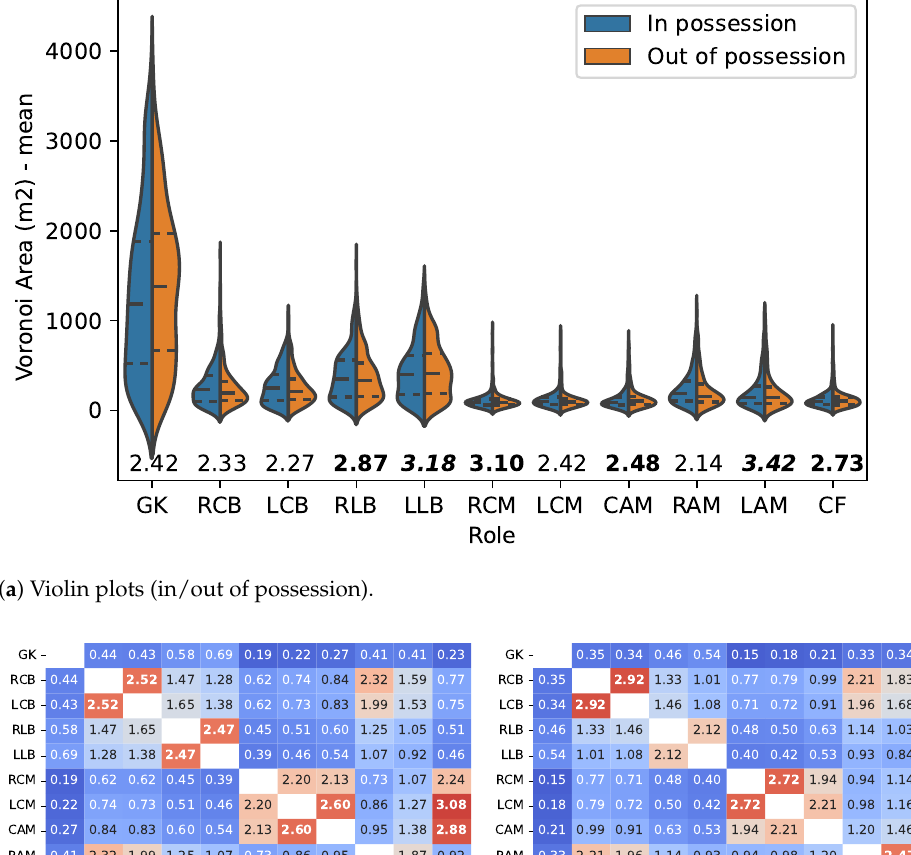
( b ) KS heatmap (in possession). Figure 2. Players’ Voronoi area probability density function in the 4-2-3-1 team formation. Note: Violin plots ( a ) and heatmaps ( b , c ) comparing players’ Voronoi area probability density function (less similar in blue, more similar in red). (The differences that are statistically not relevant are highlighted in bold ). When the analysed teams were in possession of the ball, the non-significant differences were observed between players of the same sector, namely, between central backs (RCB and LCB), lateral defenders (RLB and LLB), and midfielders (CAM and LCM), and also between the Centre Forward (CF) and two midfield interior players (CAM and LCM). On the other hand, when the analysed teams were out of ball possession, non-significant differences remained between RCB and LCB and between CAM and CF. Except for the new non-significant differences between the defensive midfielders (RCM and LCM) and between wingers (RAM and LAM), all the others were now statistically significant. The same process was applied to the 3-4-1-2 team formation (TF). Players’ VA distri- bution is presented in the violin plots and their Kolmogorov-Smirnov statistics heatmaps in Figure